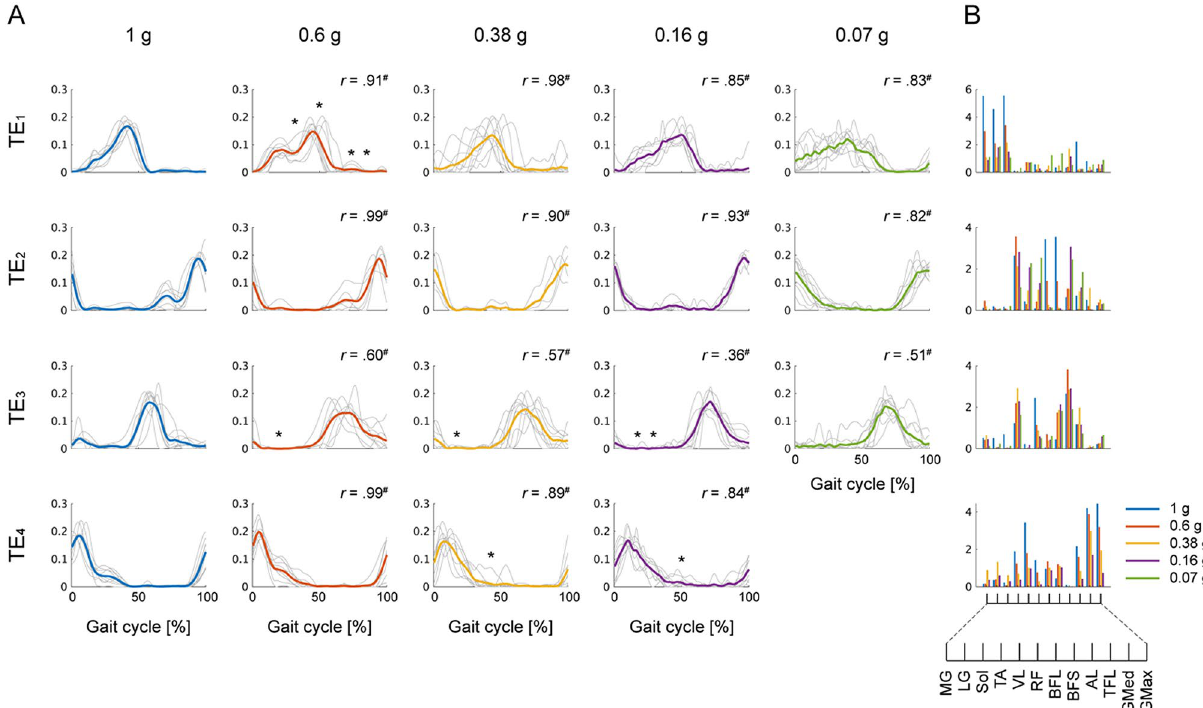
Figure 6. Modules clustered based on the temporal modules. Modules extracted from the EMG data matrix at Fr ~ 0.25 are shown. ( A ) The line plots represent a temporal module. Temporal modules identified from all participants were classified into a set of 4 clusters in each gravity level. The grey individual line indicates a temporal module identified in each participant, and the coloured solid line indicates the average. ( B ) The bar graphs indicate spatial modules averaged across participants. The different columns of the temporal modules and different colours of the spatial modules represent the 5 different gravity levels. The temporal modules corresponding to the same cluster, i.e., TE 1 to TE 4 , and the corresponding spatial modules are arranged in the same row. The similarity of the temporal modules between the gravity condition of 1 g and each of the other gravity levels in each cluster (TE 1-4 ) is shown as the correlation coefficient ( r ). Symbols (*, #) indicate a significant difference in the activation coefficients of all or each phase; * p < 0.05 and # p < 0.01.